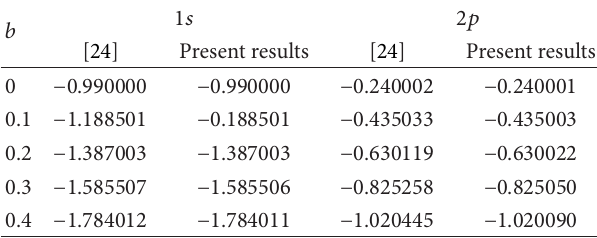
Table 4: When 𝑐 = 1 , 𝑏 ̸= 0 , and 𝜆 = 200 , comparison of 1𝑠 and 2𝑝 energy eigenvalues obtained in the present study with results of [24] for different 𝑏 screening parameters in Rydberg